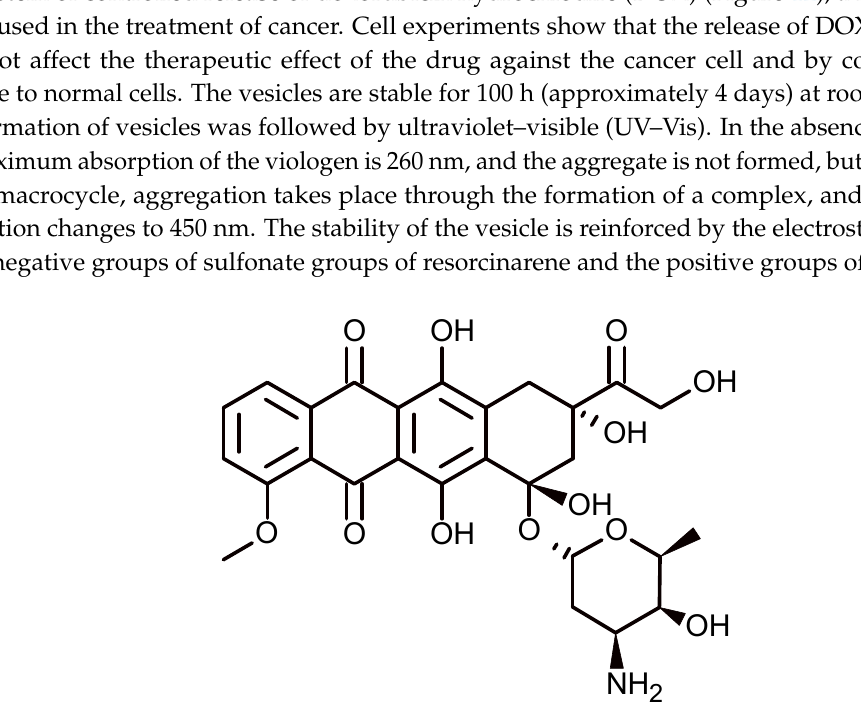
Figure 12. Doxorubicin structure.